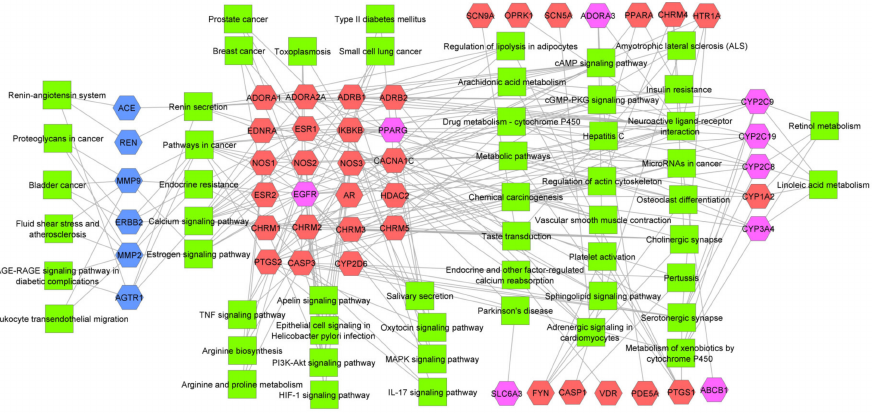
Figure 1. Network between proteins (target—red, off-targets—blue, common targets—purple) and enriched metabolic pathways